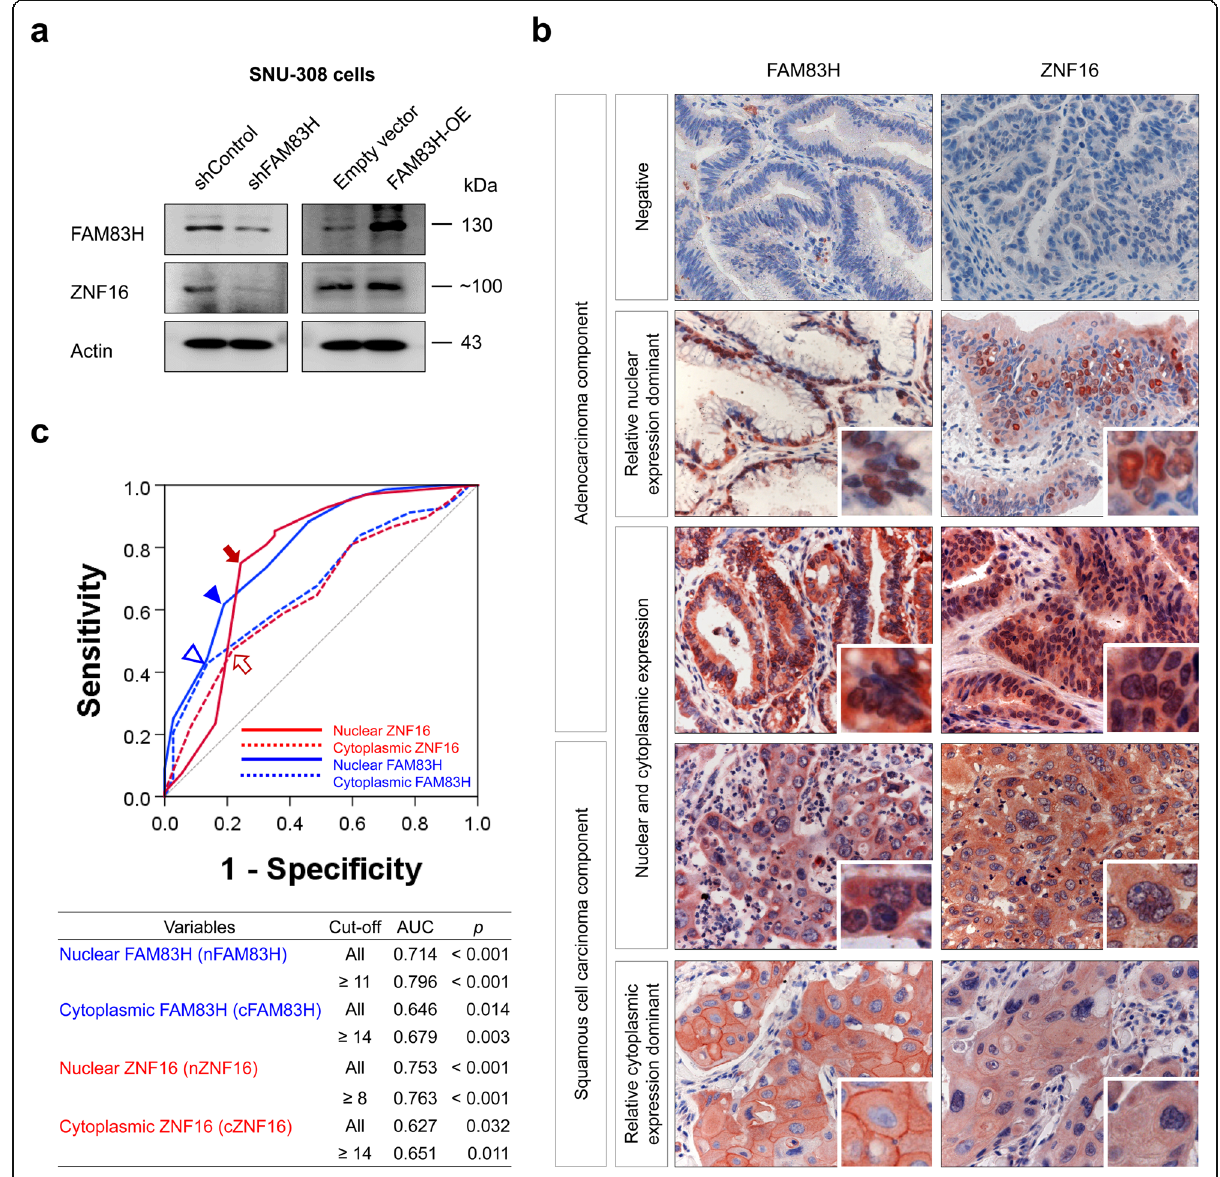
Fig. 1 Western blot and immunohistochemical expression of FAM83H and ZNF16 and statistical analysis in gallbladder carcinomas. a SNU-308 gallbladder carcinoma cells were transfected with control shRNA, shRNA for FAM83H, empty vector, or a vector overexpressing FAM83H (FAM83H-OE) and performed western blot for FAM83H, ZNF16, and actin. b FAM83H and ZNF16 are expressed in both the cytoplasm and nuclei of cancer cells. Original magnification: × 400. c Receiver operating characteristic curve analysis to determine cut-off points for the expression of nuclear FAM83H (blue arrowhead), cytoplasmic FAM83H (empty blue arrowhead), nuclear ZNF16 (red arrow), and cytoplasmic ZNF16 (empty red arrow). The cut-off points indicate the point of the highest area under the curve (AUC) to predict the death of gallbladder carcinoma